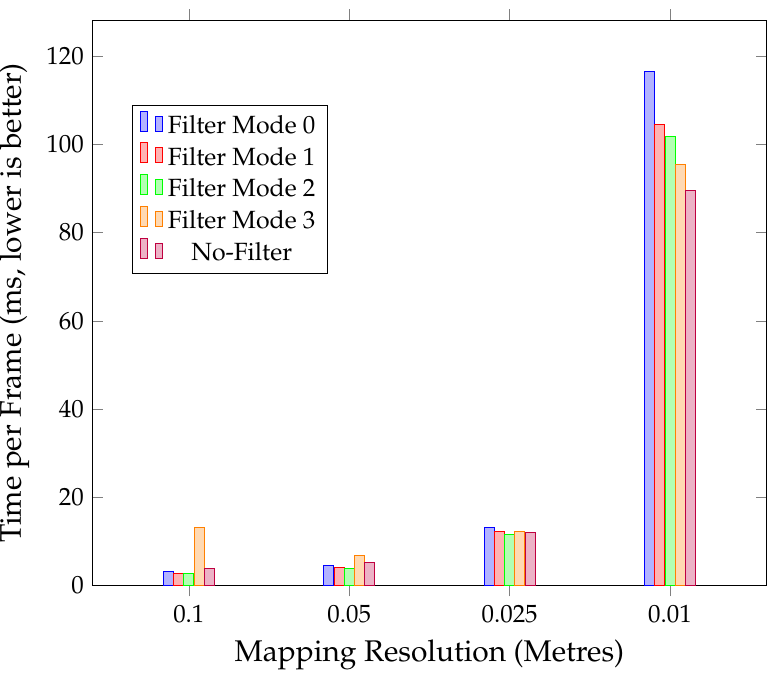
Figure 6. Asus Zephyrus G14 NanoMap GPU performance.